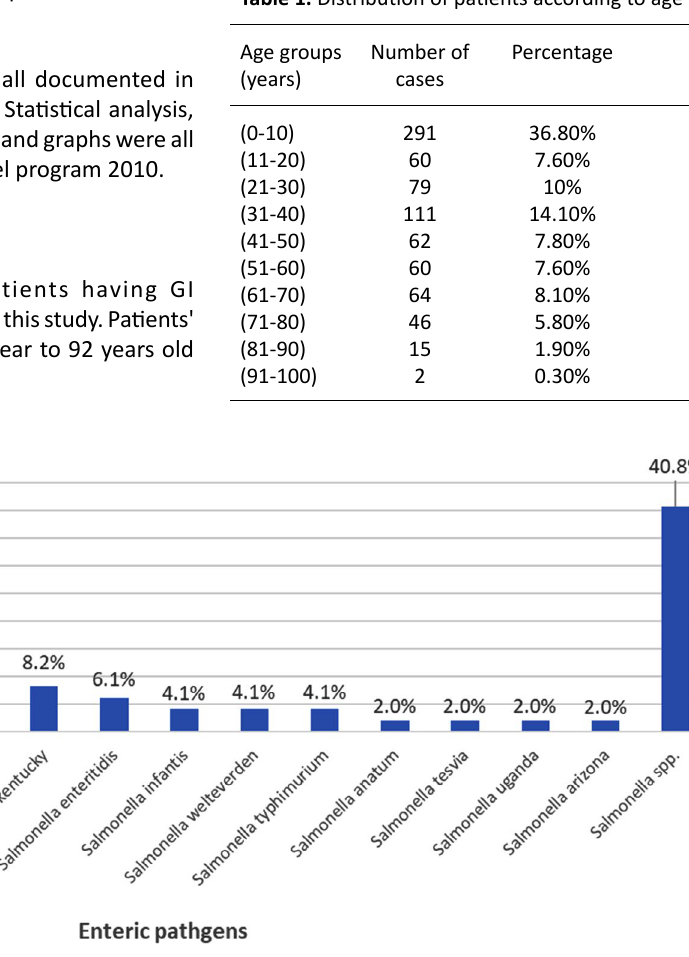
Table 1. Distribution of patients according to age